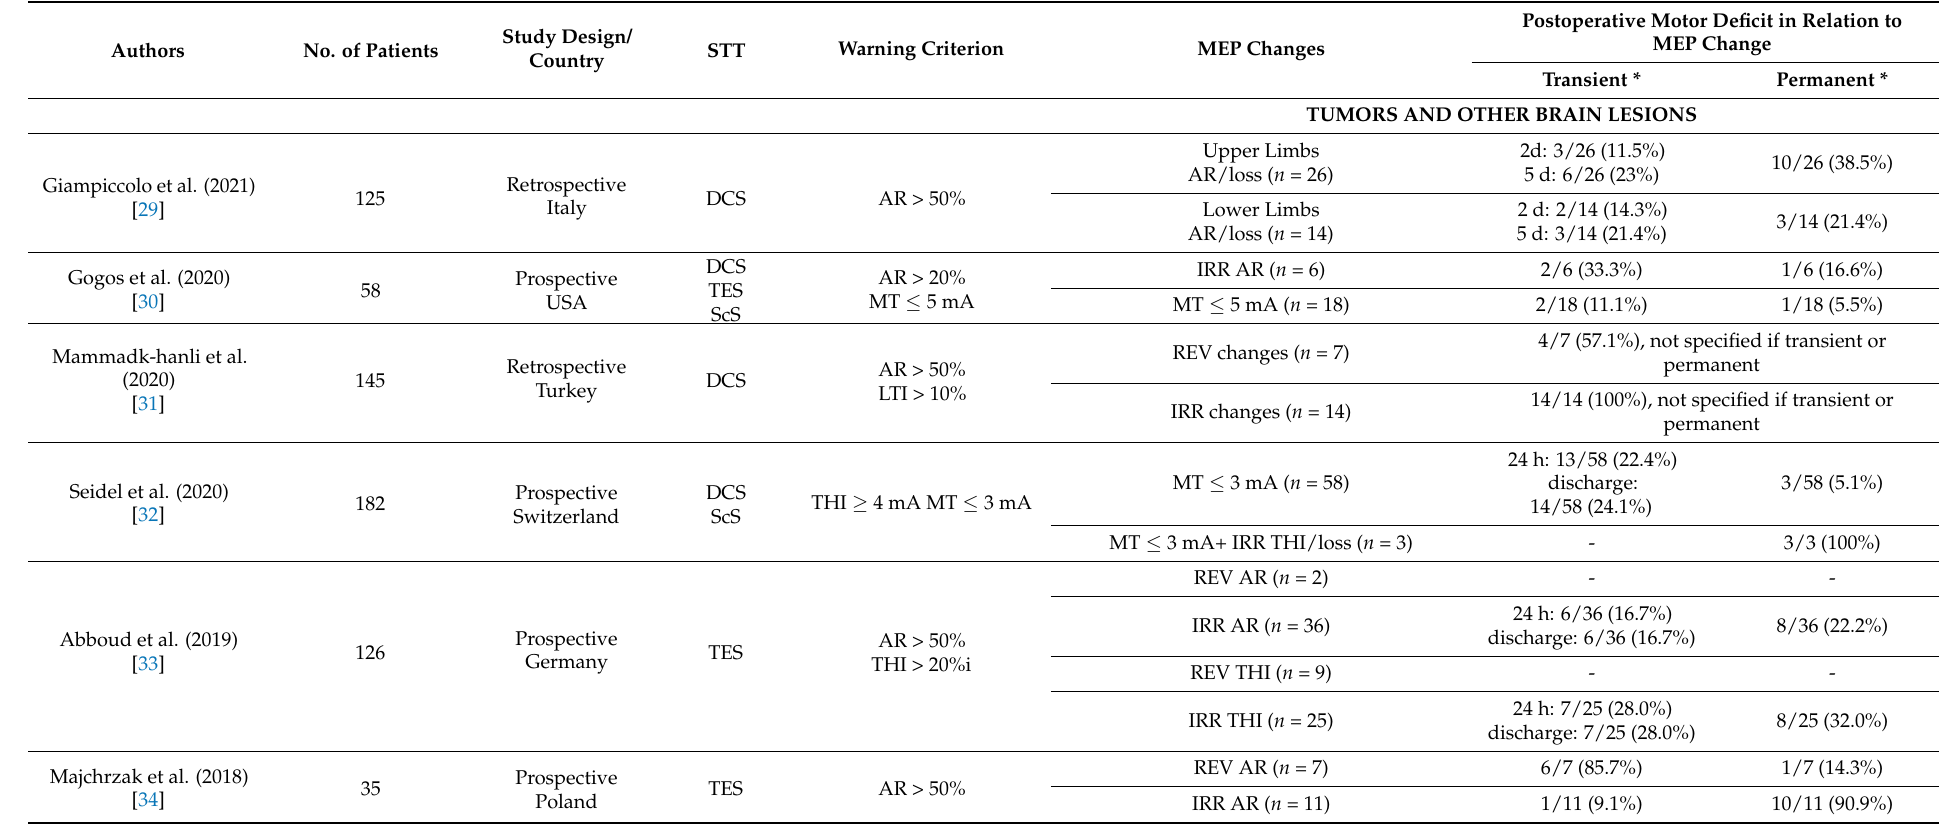
Table 1. Overview of the included studies with tumor and epilepsy surgery. Number of included patients, study design, stimulation parameters, MEP warning criteria, number of patients who met these criteria, as well as the relation with postoperative motor deficits are presented. *: The results are presented as the total number and percentage of patients with the indicated MEP warning criterion who developed a transient and permanent motor deficit. In studies with outcome reporting at distinct time-points, the results are presented as the total number and percentage of patients with the indicated MEP warning criterion who had a new postoperative motor deficit still present at the indicated time-point that resolved thereafter. #: Permanent motor deficit in 13/25 = not assessable. Transient motor deficit in 1/25 = not assessable. (The absence of cases with a deficit is indicated by the symbol